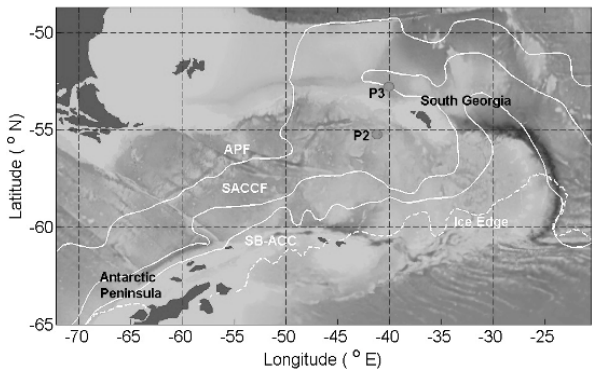
Figure 1. Map of study area in the Southern Ocean showing the locations of P3 and P2,. APF stands for the Antarctic Polar Front, SACCF for Southern Antarctic Circumpolar Current Front and SB- ACC Southern Boundary of Antarctic Cirumpolar